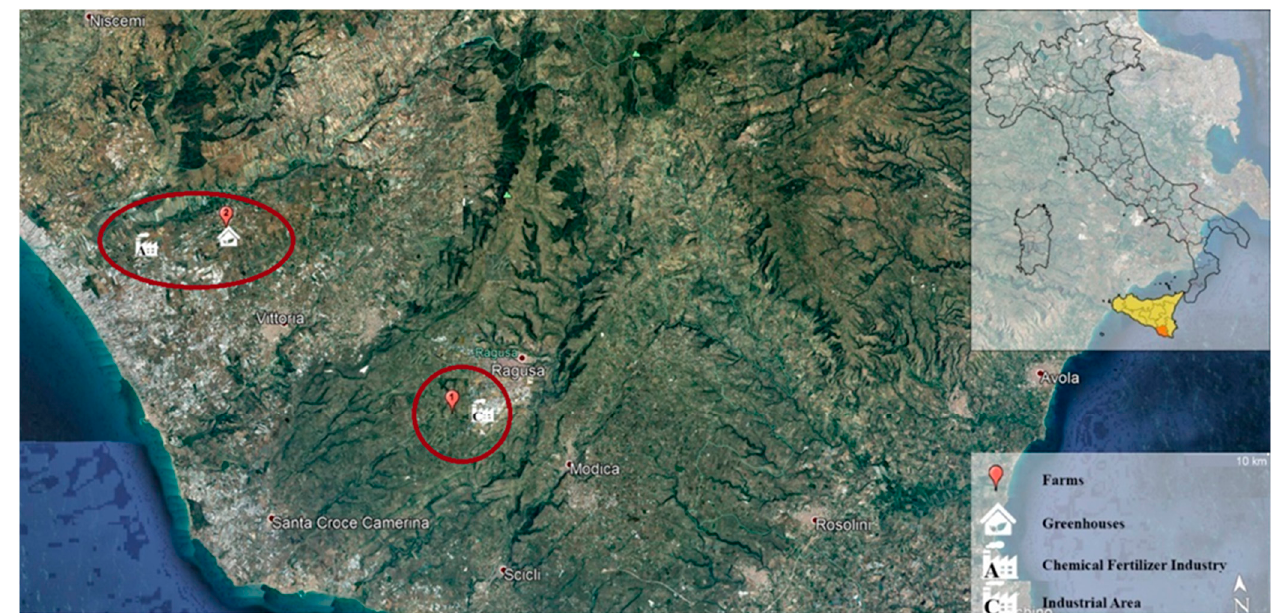
Figure 1. Map of the province of Ragusa, Italy, with geolocation of the two farms (farm 1, at about 3.7 km form an industrial area; farm 2, at about 400 mt from a greenhouse and 6.0 km from a chemical fertilizer factory) and anthropogenic activities.